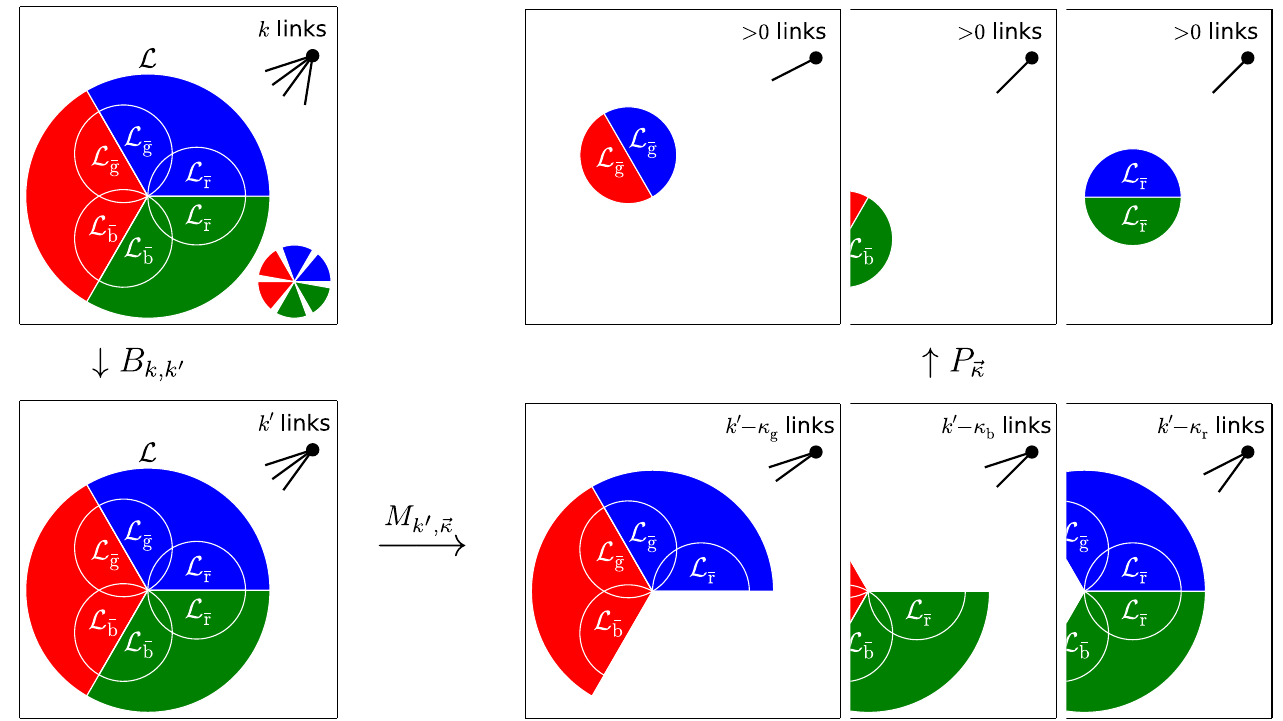
, we have to average over different link constellations color , L ¯ , and L ¯ are connected at the same time. This is r g b